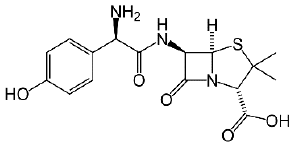
Figure 1. The structure of amoxycillin